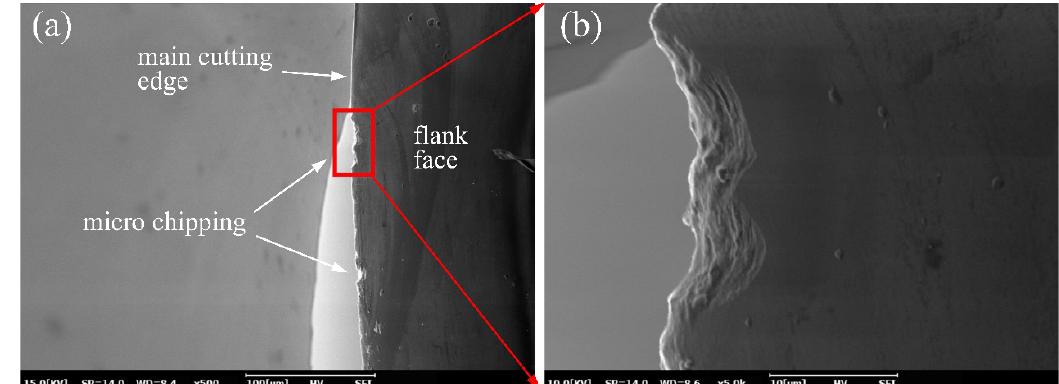
Figure 12. The calculated power spectrum density of the cross-sectional profile height between the simulated and the machined surface. 4.1. Effects of the Tool Wear In single point diamond turning, the diamond tool is directly involved in the cutting process, and the tool wear has multiple effects on the cutting process, including the increasing cutting force, the higher cutting temperature and the deteriorated surface quality [18]. The geometry of the diamond tool directly affects the surface topography after machining, and the surface roughness strongly depends on the sharpness and the integrity of the cutting edge [19]. As shown in Figure 11, the surface profile height of the experimental result is greater than the